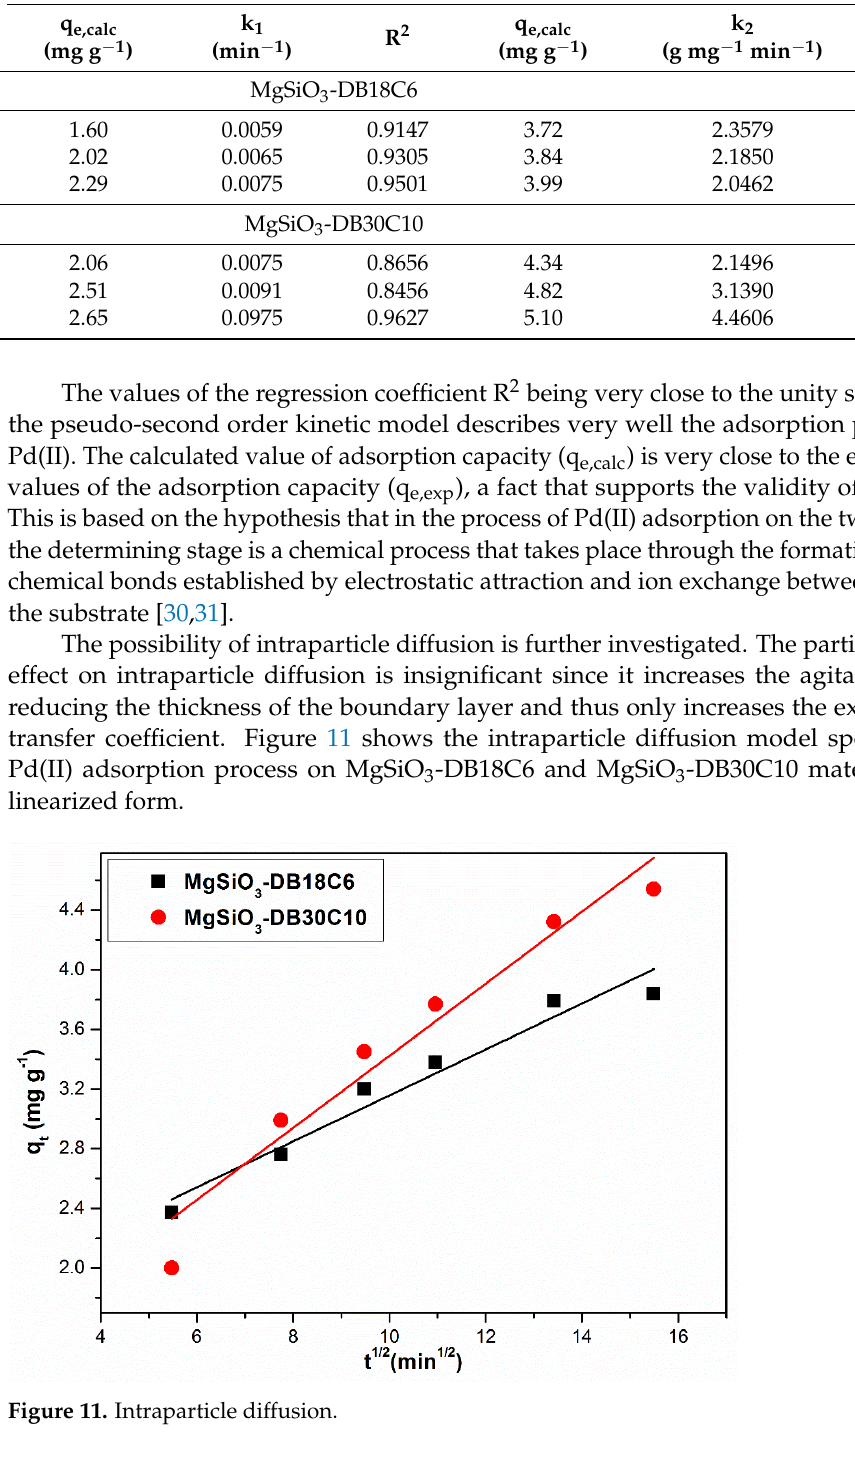
Table 2. Kinetic parameters for Pd(II) adsorption onto adsorbent materials.